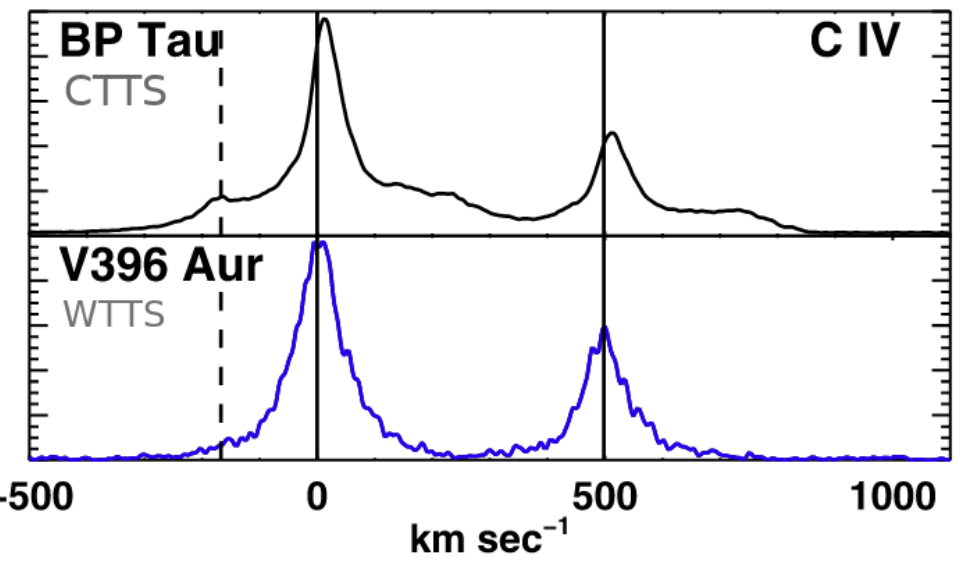
Figure 3. Comparison of a typical CTTS’s line profile ( top ), here C IV , and that of a weak-line T Tauri star (WTTS) of comparable mass ( bottom ). The dashed line marks the location of emission from fluorescent H 2 . From Ardila et al. [50]. c AAS. Reproduced with (cid:13)